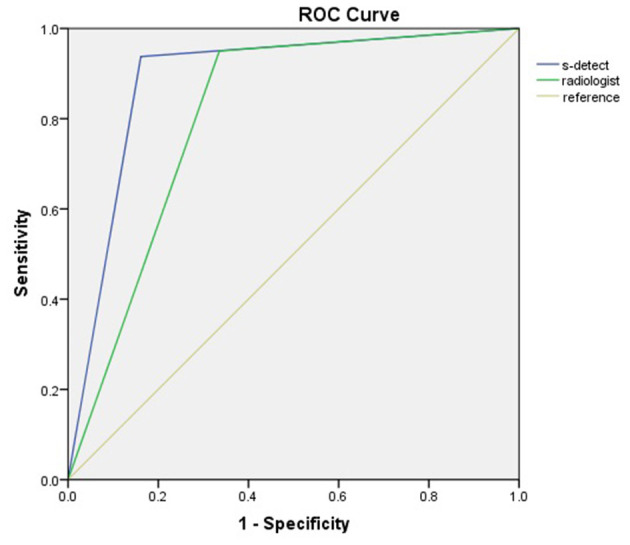
ROC curves of asymptomatic patients.